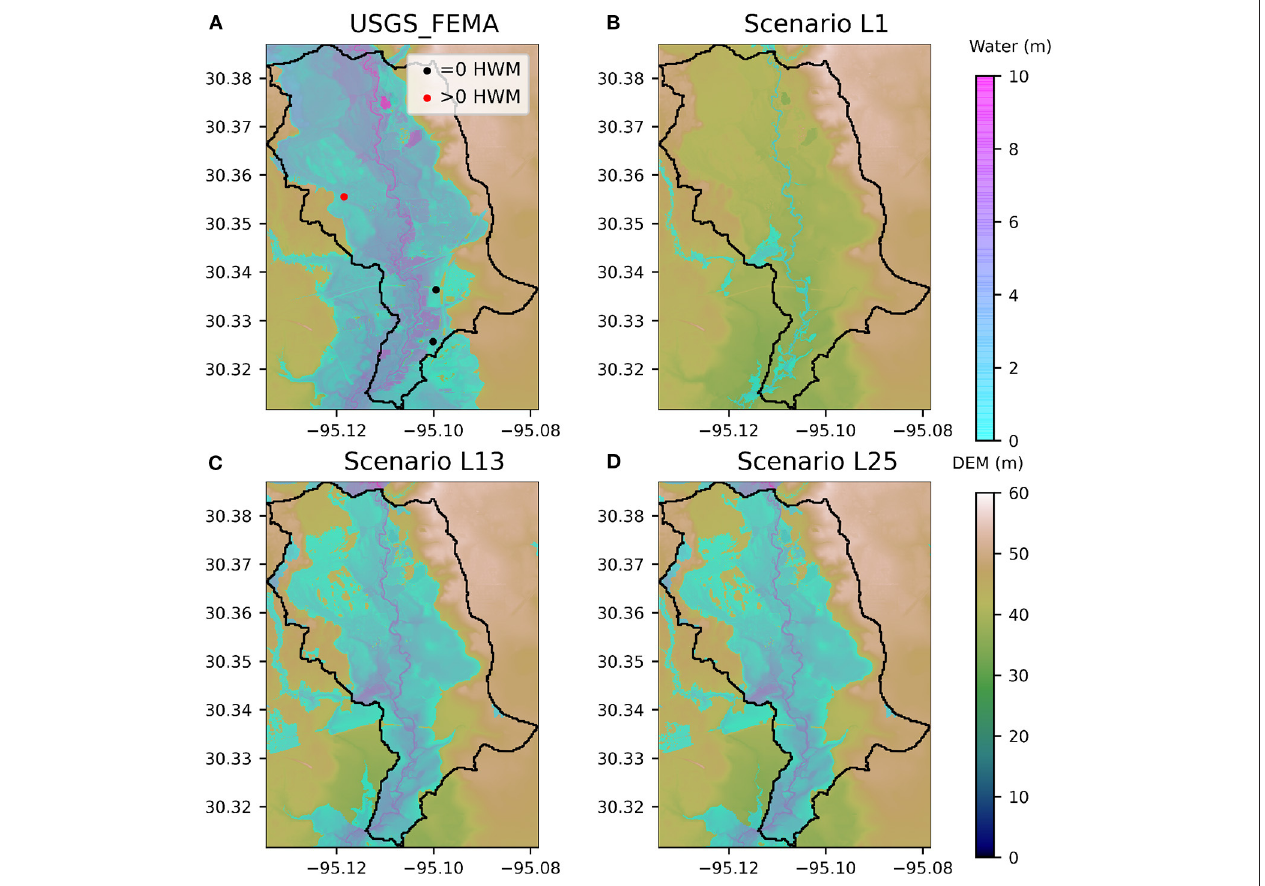
FIGURE 5 | Comparison of inundation maps: (A) observed—based on USGS-FEMA, (B–D) predicted maximum inundation from scenarios.